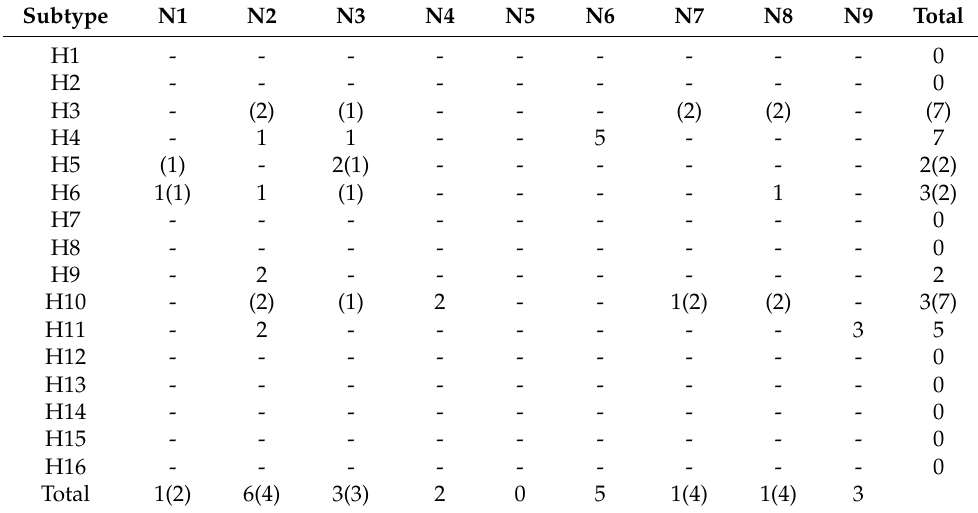
Table 3. Distribution of avian influenza virus hemagglutinin (HA) and neuraminidase (NA) subtypes. Numbers of mixed subtypes were shown in